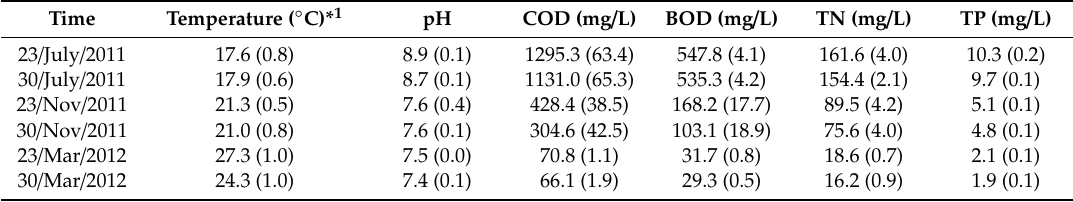
Table 2. Mean and standard deviation on indicators of water quality treated by micro-nano bubbles. Chemical oxygen demand (COD); biological oxygen demand (BOD); total nitrogen (TN), and total phosphate (TP).